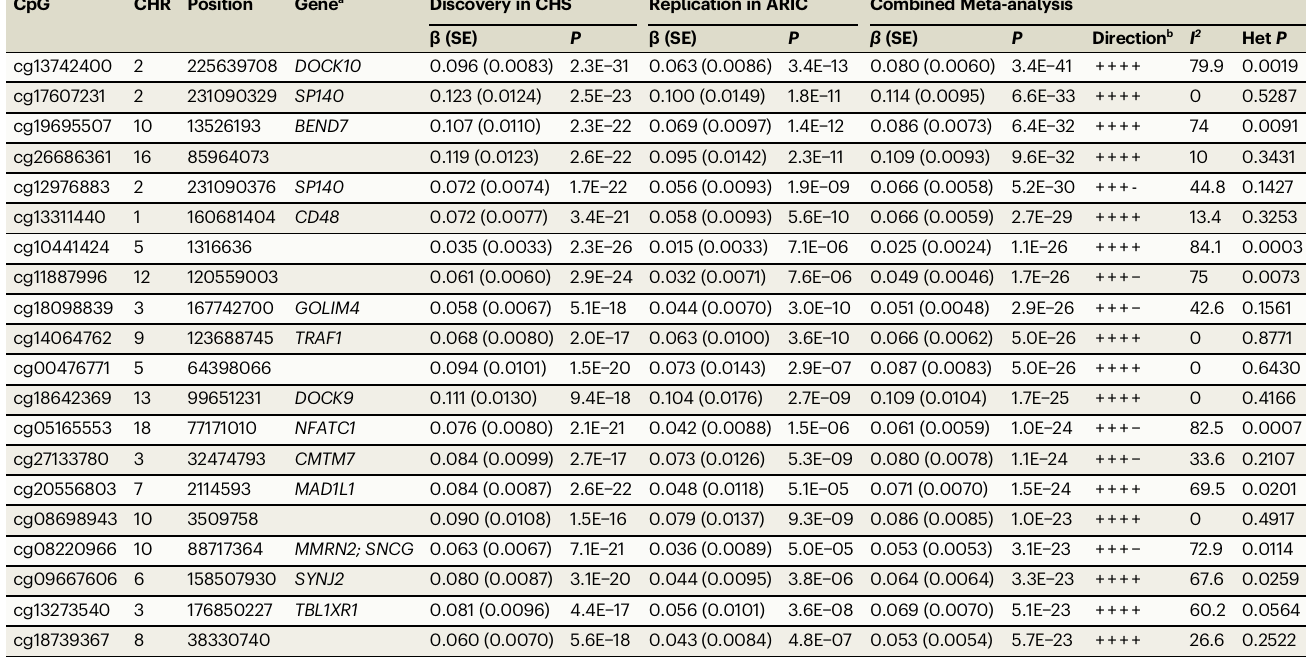
Table 3 | Top 20 TET2 -CHIP-associated CpGs CpG CHR